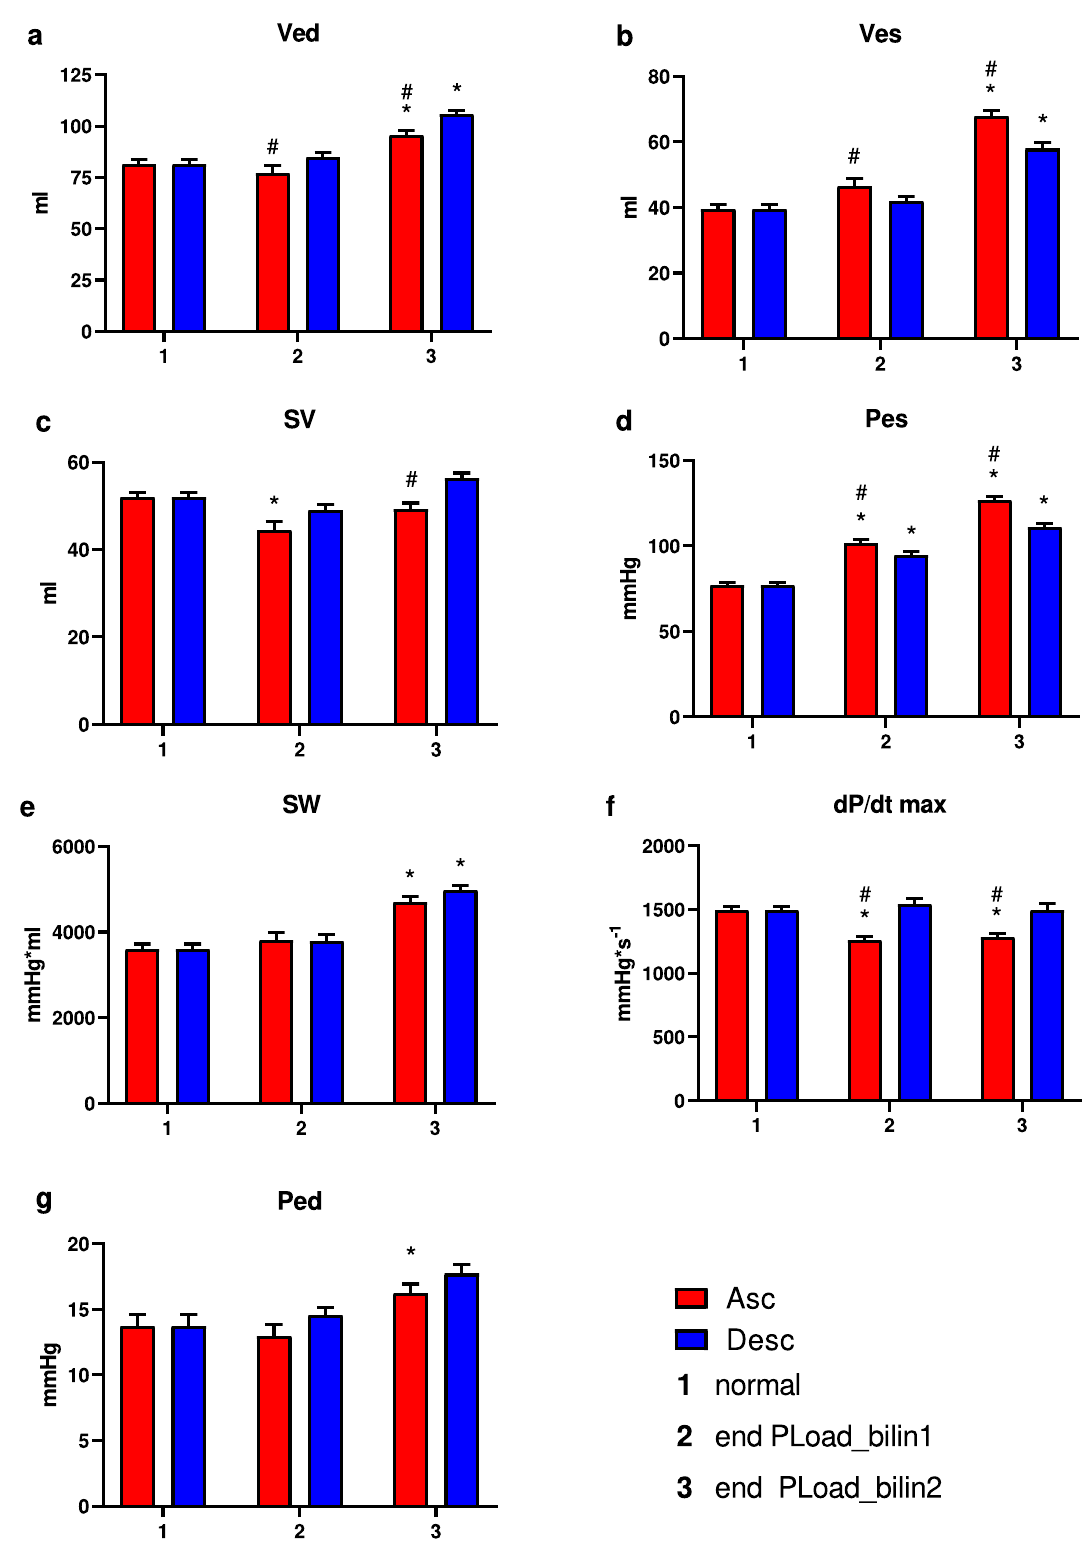
Figure 5. Ventricular parameters under a normal load (a) and at the end of the first (PLoad bilin1) and the second (PLoad bilin2) phases of the afterload interventions by either occlusion of the ascending aorta (ASC) or inflation of a balloon catheter in the descending aorta (DESC). (MW ± SD; *p < 0.05 vs. normal load; # p < 0.05 vs. DESC; Ved = end-diastolic volume, Ves = end-systolic volume, SV = stroke volume, Pes = end-systolic pressure, SW = stroke work, dP/dtmax = maximal rate of intraventricular pressure change, Ped = end-diastolic